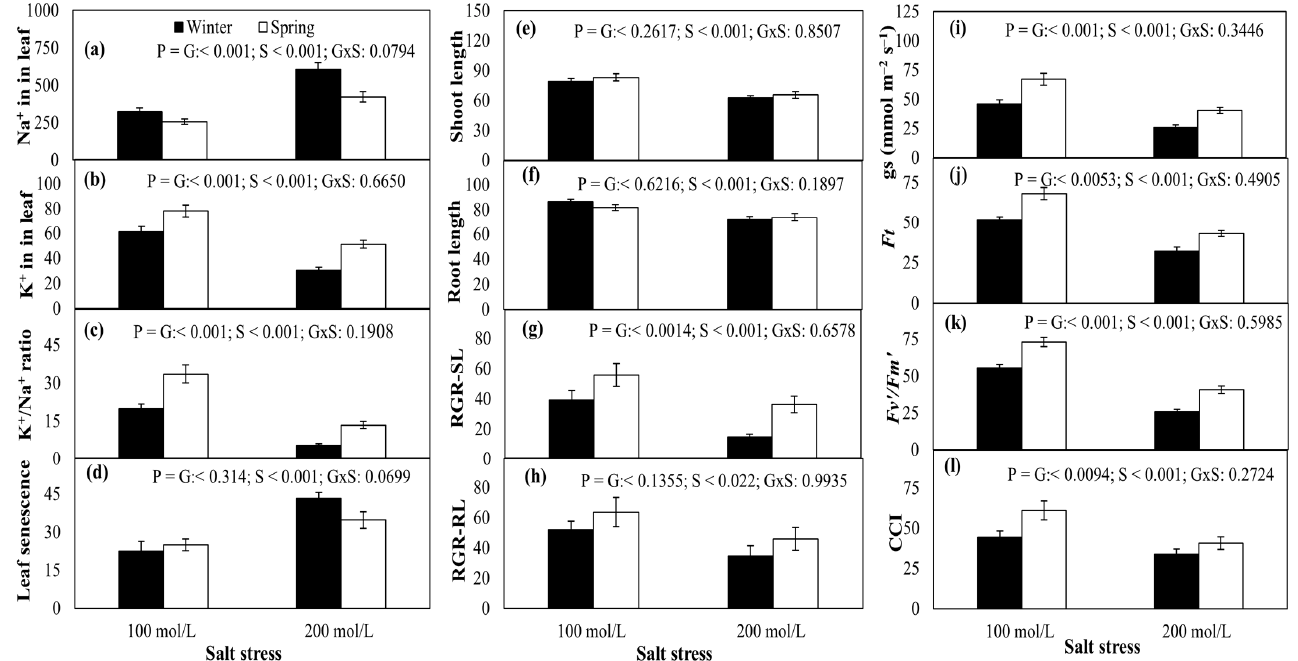
Figure 1. Effect of salt stress on winter and spring wheat. Diagrams are based on value of % control (salt-treated/control ∗ 100) of Na + in leaves ( a ), K + in leaves ( b ), K + /Na + ratio ( c ), leaf senescence % ( d ), shoot length (SL) ( e ), root length (RL) ( f ), relative growth rate of root length (RGR-RL) ( g ), relative growth rate of shoot length (RGR-SL) ( h ), stomatal conductance ( gs ) ( i ), instantaneous chlorophyll fluorescence ( Ft ; j ), quantum yield of photosystem II (Fv ′ /Fm ′ ; k ), and chlorophyll content index (CCI; l ).